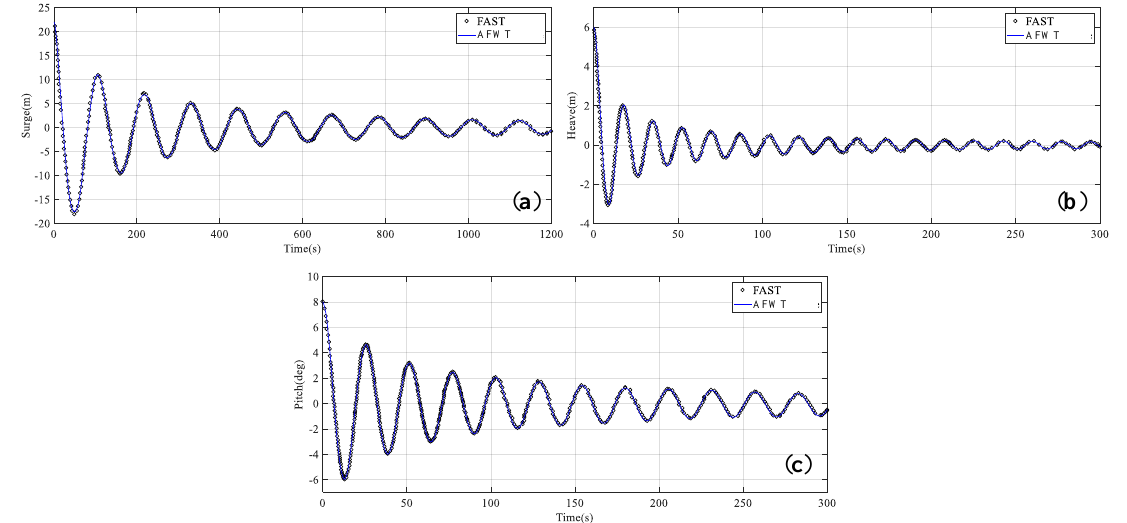
Energies 2019 , 12 , x FOR PEER REVIEW Figure 6. Dynamic response of the original Model 1 under the free decay condition calculated by FAST and AFWT: ( a ) surge decay; ( b ) heave decay; and ( c ) pitch decay.